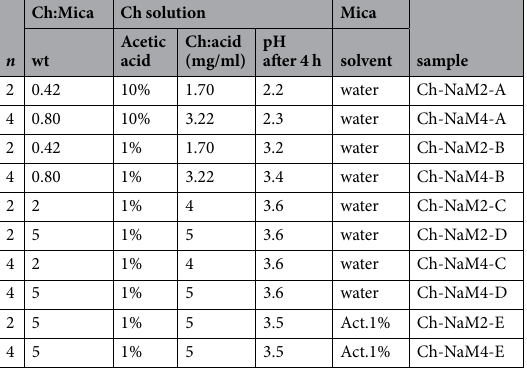
Table 2. Synthesis parameters and sample name of Ch-NaM n ( n = 2 and